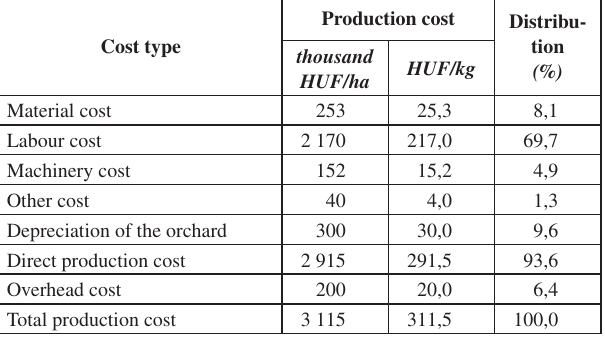
Table 2: The Production Cost of a Raspberry Orchard Cultivated on a Good Standard Relating to Cost Types in a Good Year Regarding a Yield Level of 10 Tons per One Hectare